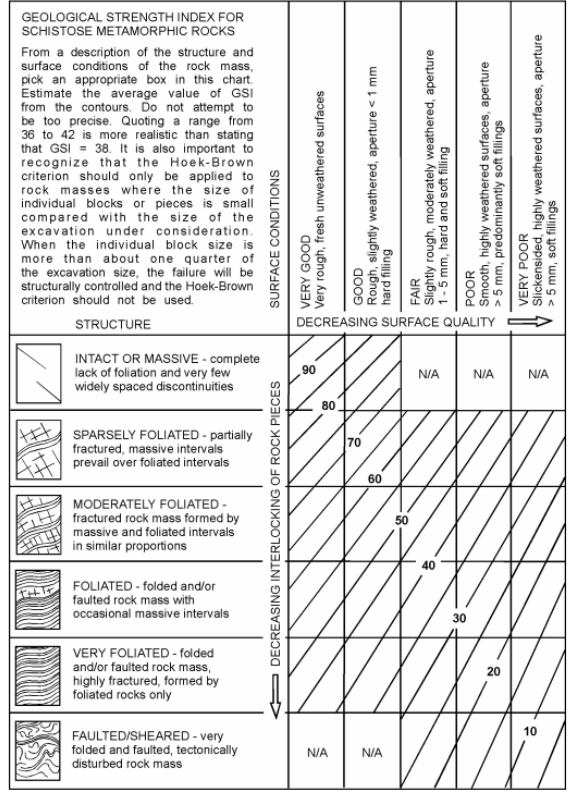
Figure A6. GSI chart for other rock masses [25].